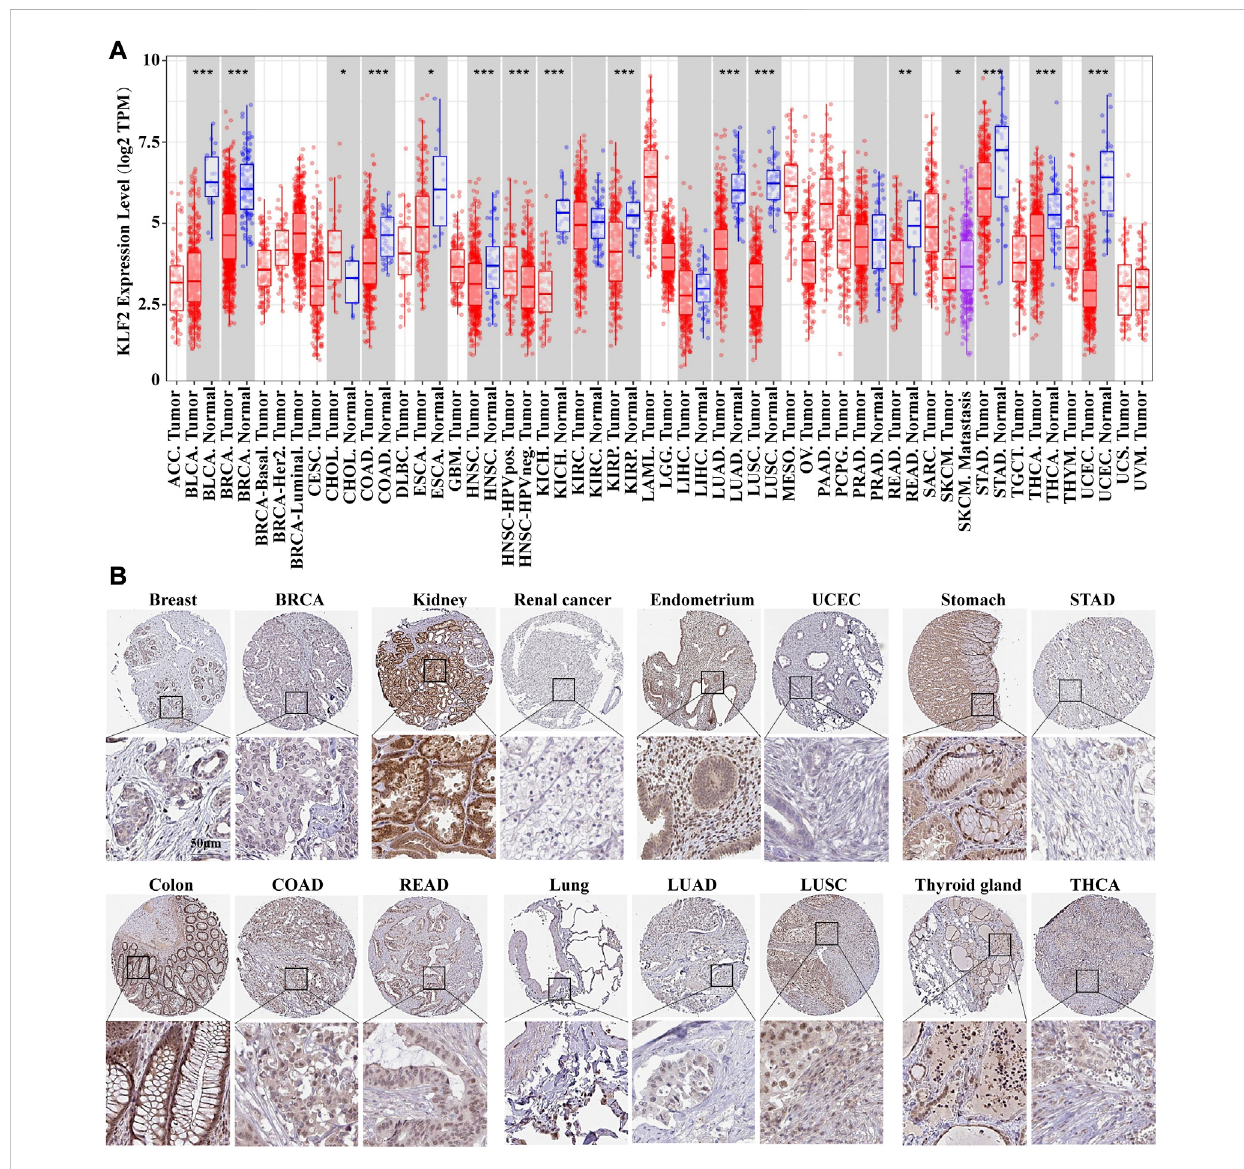
FIGURE 1 The expression of KLF2 in breast cancer and pan-cancer . (A) The expression of KLF2 in pan-cancer was evaluated using the TIMER database. (B) To investigate the protein expression of KLF2, an immunohistochemistry assay was performed on both paracarcinoma and tumor samples.